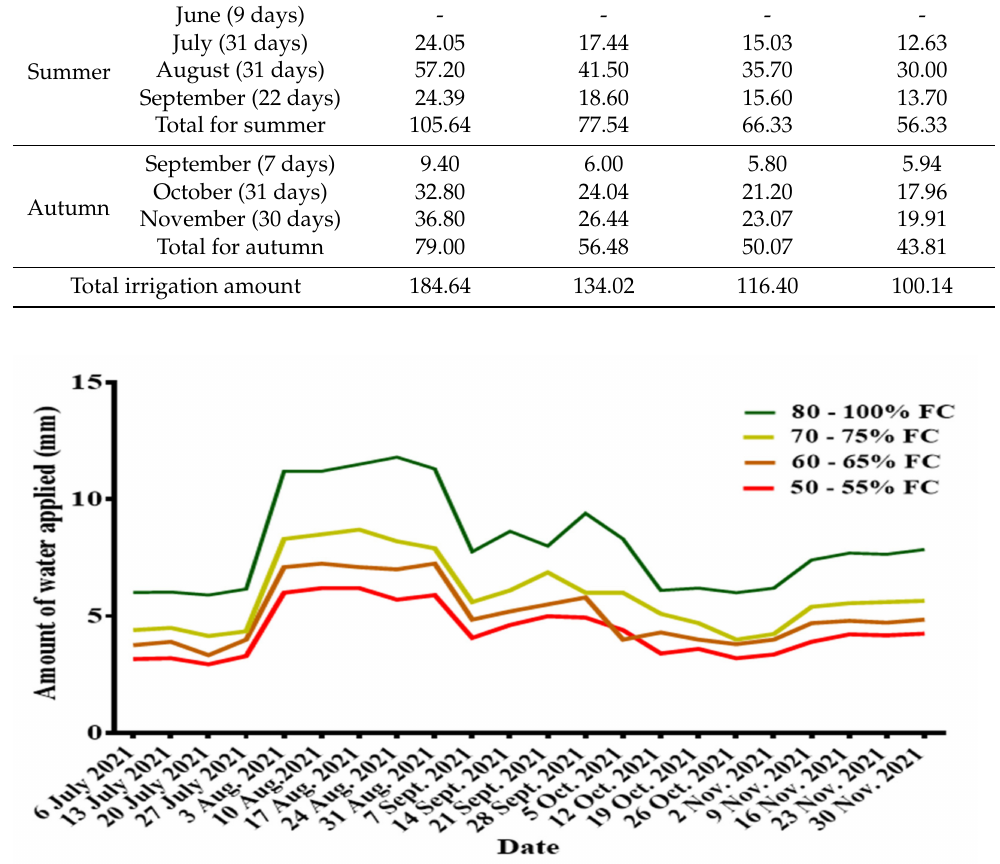
Figure 3. Variations in soil water